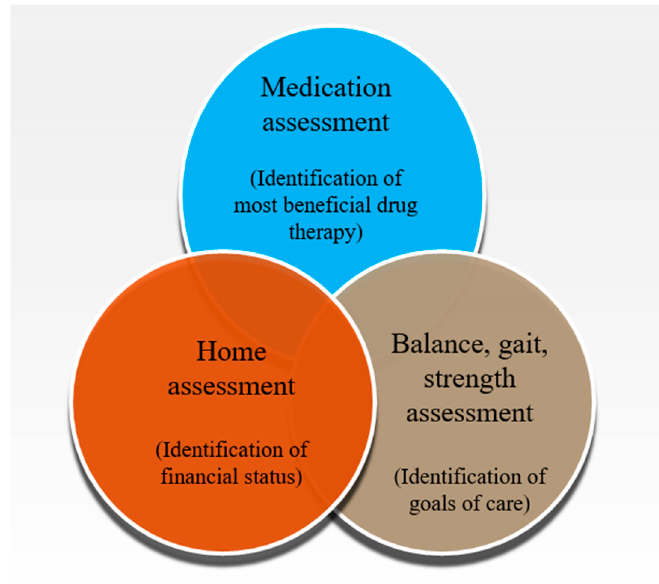
Figure 3. Management plans for polypharmacy.